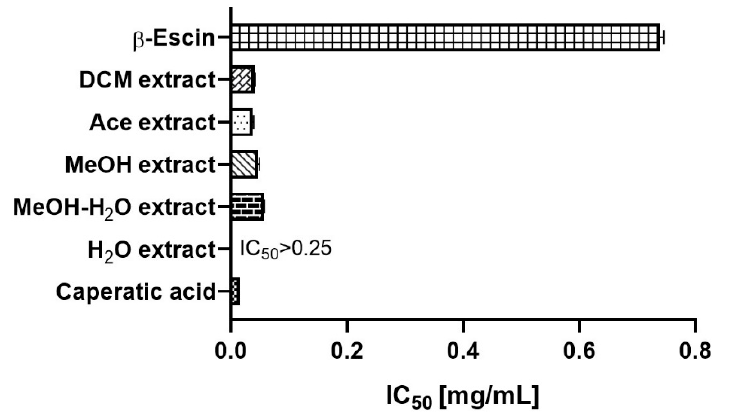
Figure 5. Inhibition of hyaluronidase by the P. glauca and extracts as well as by β -escin (served as a standard in this assay). Results are presented as IC 50 mean values (mg/mL) ± SEM ( n = 4—for P. glauca extracts, and caperatic acid and n = 6—for referenced: β -escin) obtained in two independent